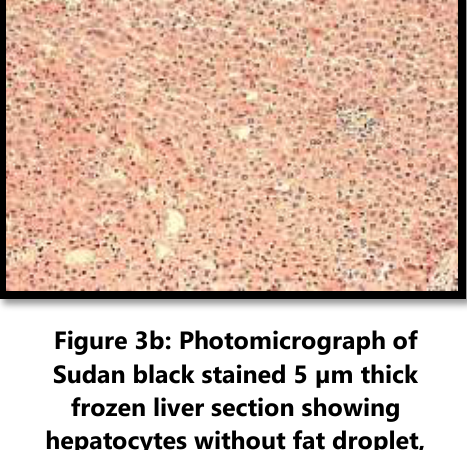
Figure 3a: Photomicrograph of H&E stained 4 µm thick section of Liver showing Portal triad (PT) of rat on control diet (group 1) at ×400.